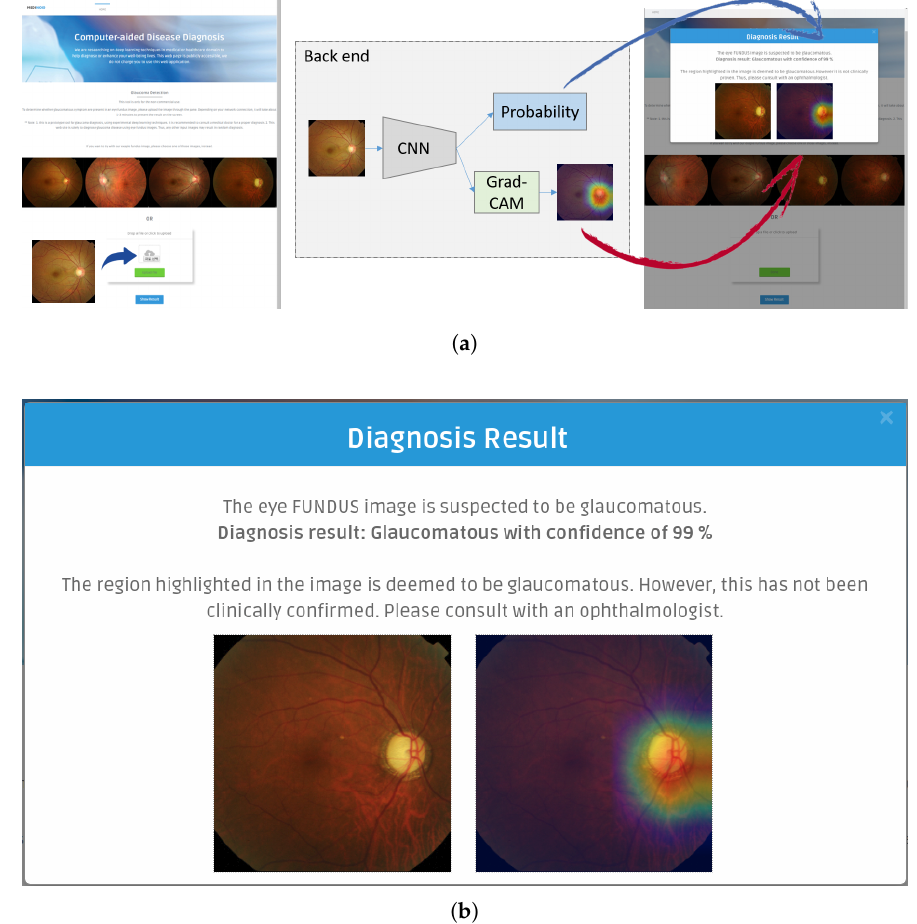
Figure 9. ( a ) Screenshots of Medinoid, a web application developed in support of computer-aided glaucoma diagnosis. Once a user has uploaded a fundus image, Medinoid will automatically screen the fundus image for the presence of glaucoma using a back-end engine that has been built on top of our most effective predictive model. If the image is diagnosed to be glaucomatous, then Medinoid will print out the diagnostic confidence and visualize the glaucomatous area. ( b ) Diagnosis result for a glaucomatous eye image, showing the diagnostic confidence and highlighting the glaucomatous area. Grad-CAM, Gradient-weighted Class Activation